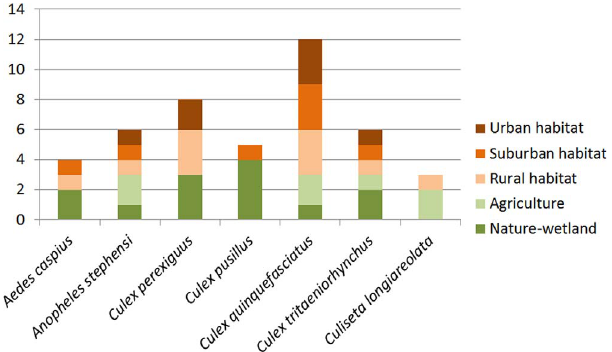
Figure 4. Numbers of positive sites for every land use category per mosquito species observed during our fi eld surveys in Qatar, September 2017 and January 2019, by any sampling method, for a total number of 20 sites.